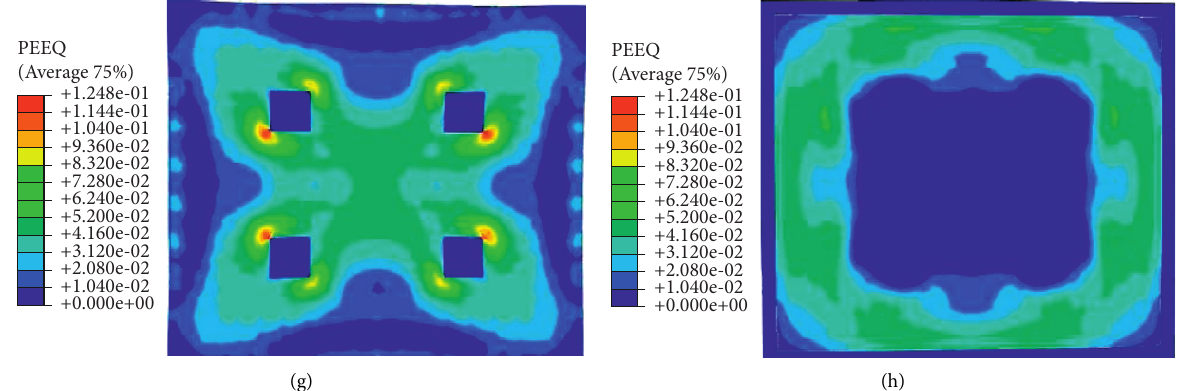
Figure 12: Deformation cloud diagram of Slab 1–Slab 4 structural model: (a) top of Slab 1; (b) bottom of Slab 1; (c) top of Slab 2; (d) bottom of Slab 2; (e) top of Slab 3; (f) bottom of Slab 3; (g) top of Slab 4; (h) bottom of Slab